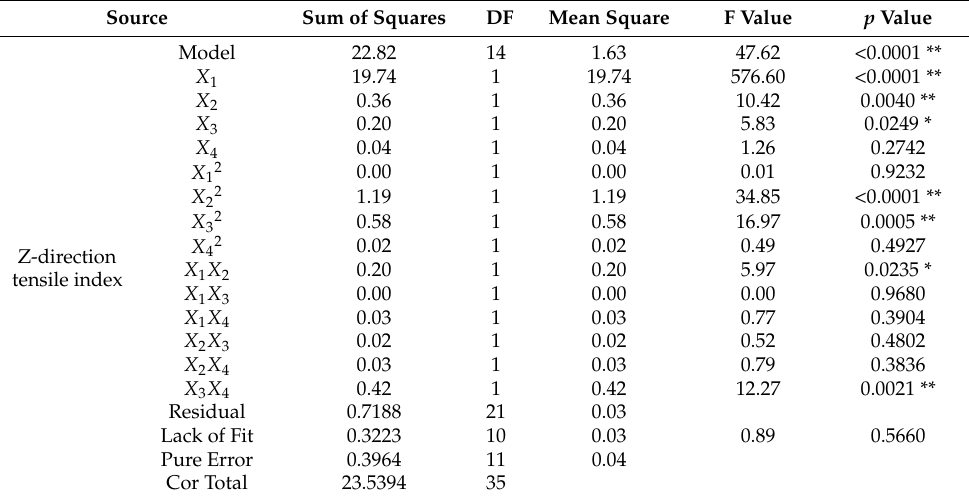
Table 4. Variance analysis of regression model of Z-direction tensile